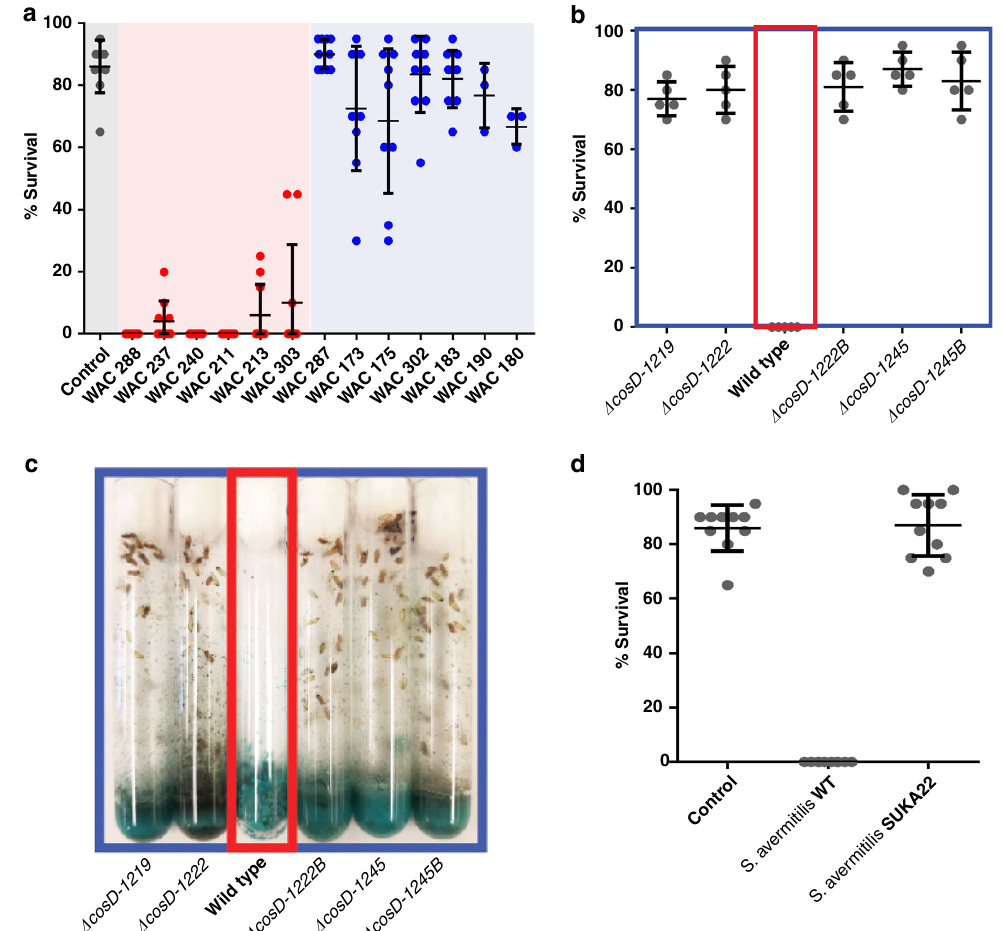
Fig. 2 Actinomycetes pose a threat to larval viability due to the production of insecticidal metabolites. a Survival rates of D. melanogaster larvae that were fed live spores of various actinomycete strains. The effect of WAC strains that produced fl y-toxic extracts are in red compared to strains that did not produce fl y-toxic extracts in blue ( n = 10). b , c Survival of larvae that were fed wild-type WAC-288 compared to strains with different cosmomycin D biosynthetic genes deleted ( n = 5). d Survival of larvae that were fed the avermectin producer S. avermitilis wild type compared to the effect of the avermectin de fi cient mutant SUKA22 ( n = 10). The measure of centre for error bars indicate the mean of each data set. Error bars of all graphs indicate the standard deviation of all biological